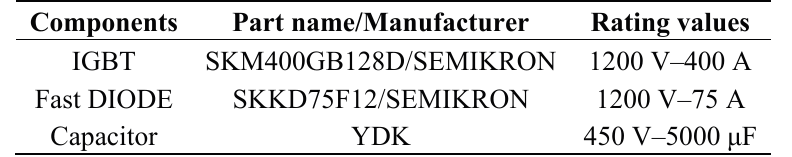
Table A1. Power transistor specifications of the three-phase VSC converter.